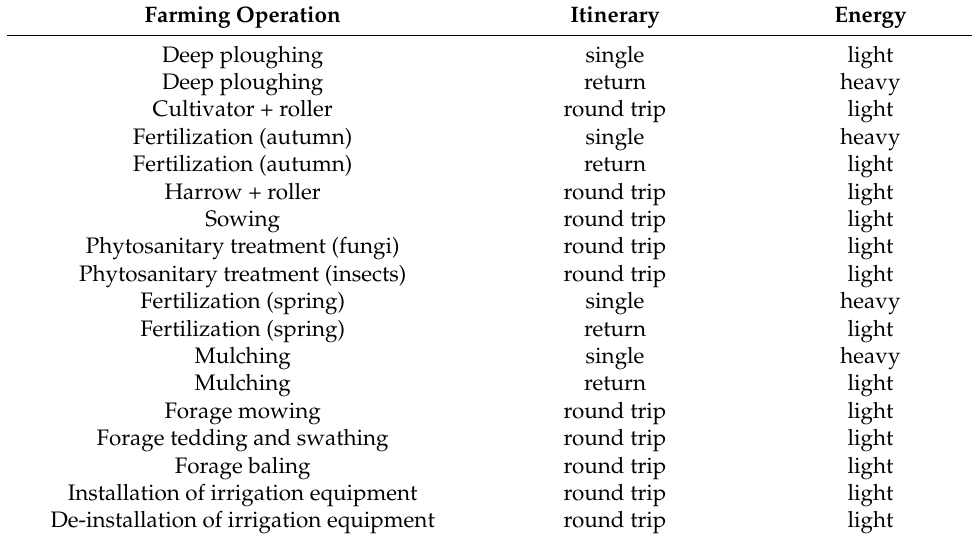
Table A2. Correspondence between farming operations and itineraries according to the energy required. Farming